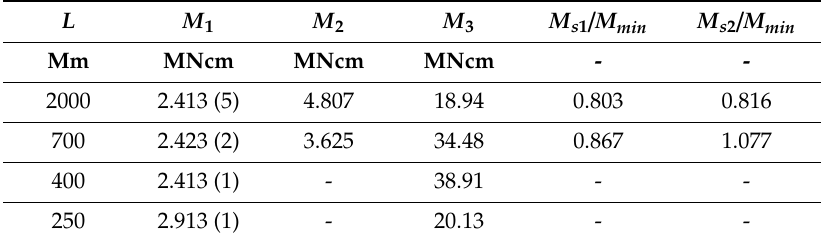
Table 3. The buckling moments M r with the corresponding number of half-waves m of buckling along the longitudinal direction of the LC-2 and the dimensionless ratio of load carrying capacities M s / M min for di ff erent lengths L